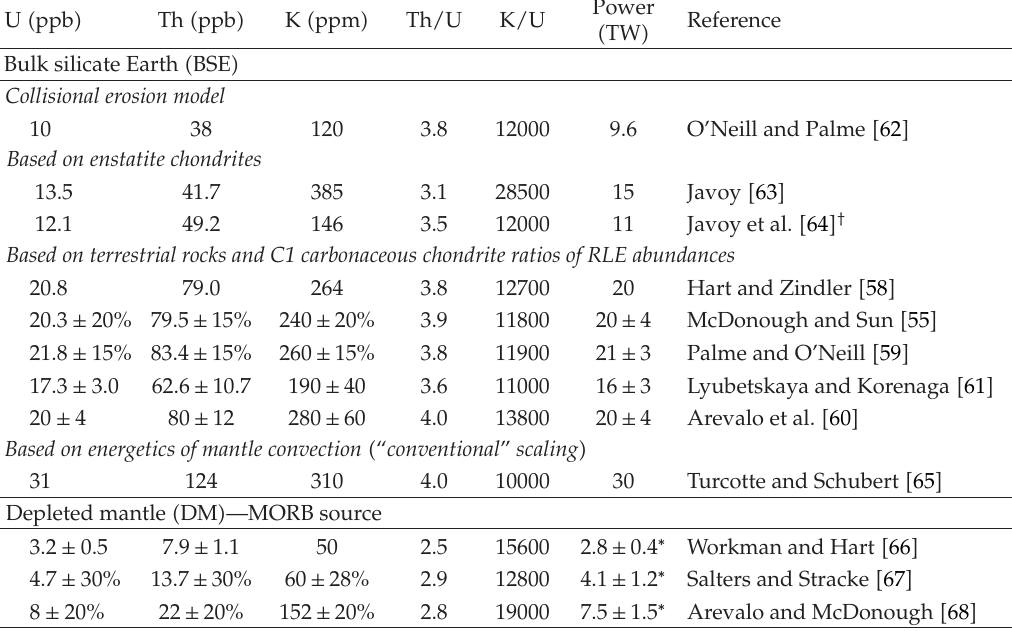
Table 2: Abundance estimates of U, Th, and K in BSE and DM. Uncertainties are included where available. U (cid:5) ppb